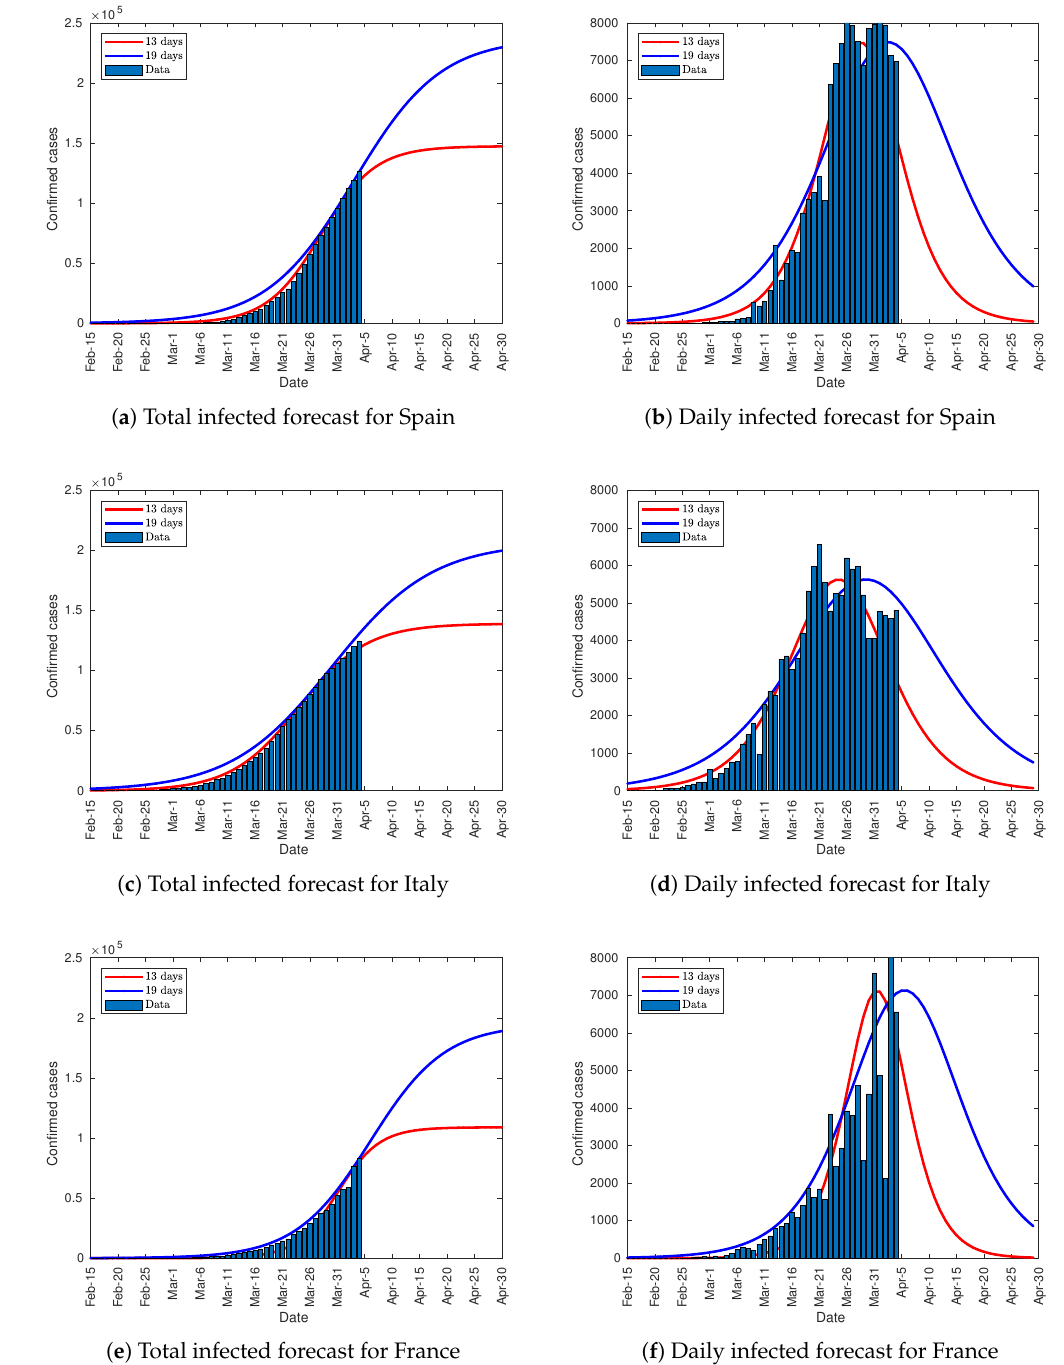
Figure 15. Total and daily infected